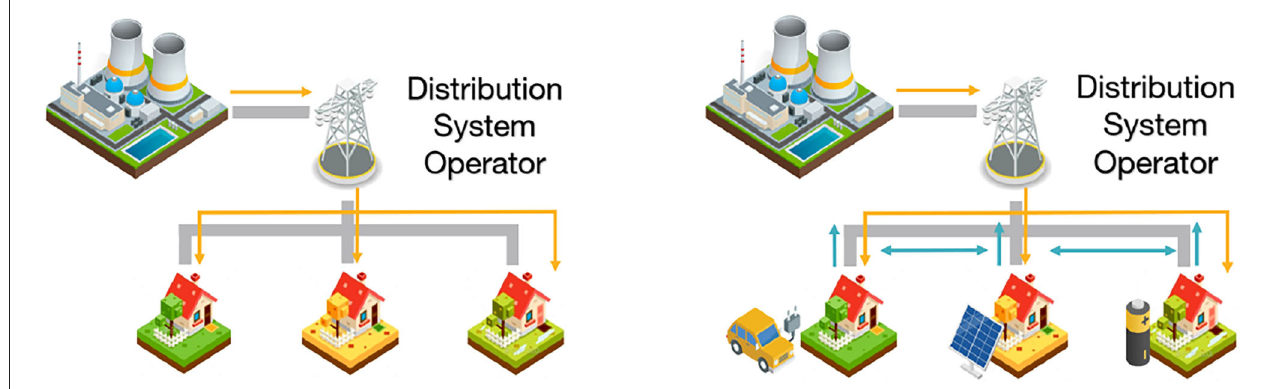
FIGURE 1 | DER enables transition from top-down energy distribution to peer-to-peer energy transfers.